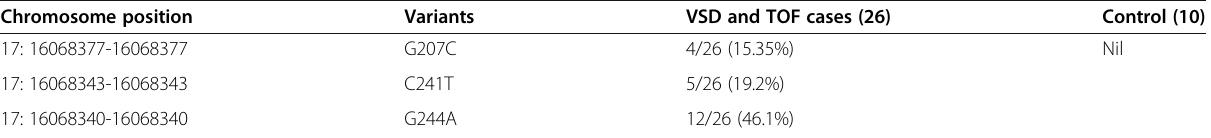
Table 3 NCOR1 variants observed during the validation by Sanger sequencing method. The variants of G207C and C241T present only in VSD cases. G244A present in three TOF cases as well Chromosome position